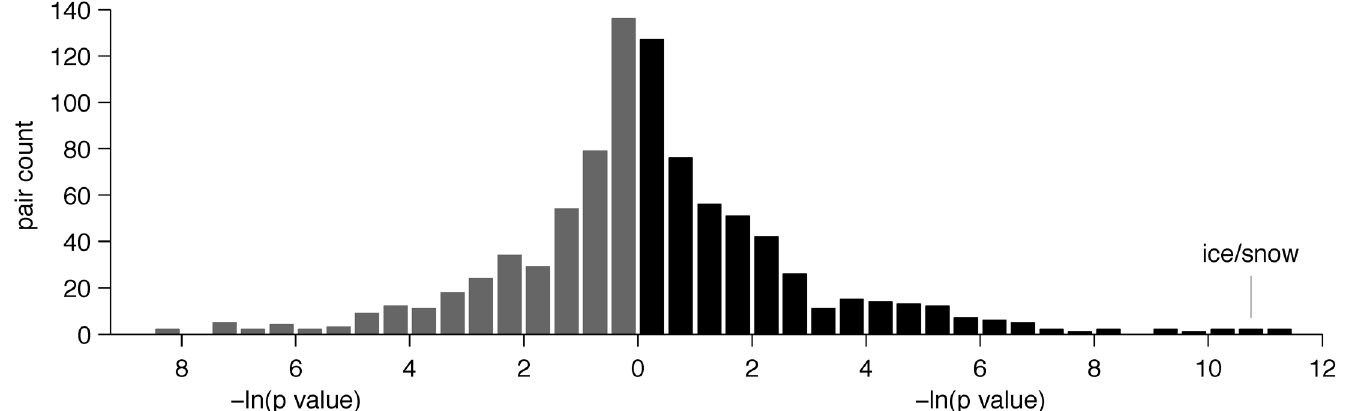
Fig 2. Results of an exhaustive analysis of meaning pairs in the IDS+ dataset. For each pair of meanings, we conducted a mixed effects logistic regression across languages, with mean temperature as the independent variable, and use of a single linguistic form for the two meanings as the dependent variable. For each pair, we compared models with and without temperature as a fixed effect, and recorded the p value associated with this comparison. Two histograms are displayed back-to-back: the gray histogram counts pairs for which the use of a single form is non-positively (zero or negative coefficient) associated with temperature, and the black histogram counts pairs for which the use of a single form is positively (positive coefficient) associated with temperature. The x-axis for each histogram shows minus natural log of the resulting p value, such that higher values correspond to greater significance; this quantity increases to the right for the positive histogram, and to the left for the non-positive histogram. The y-axis shows the number of IDS+ pairs for which that -ln( p ) value was obtained.